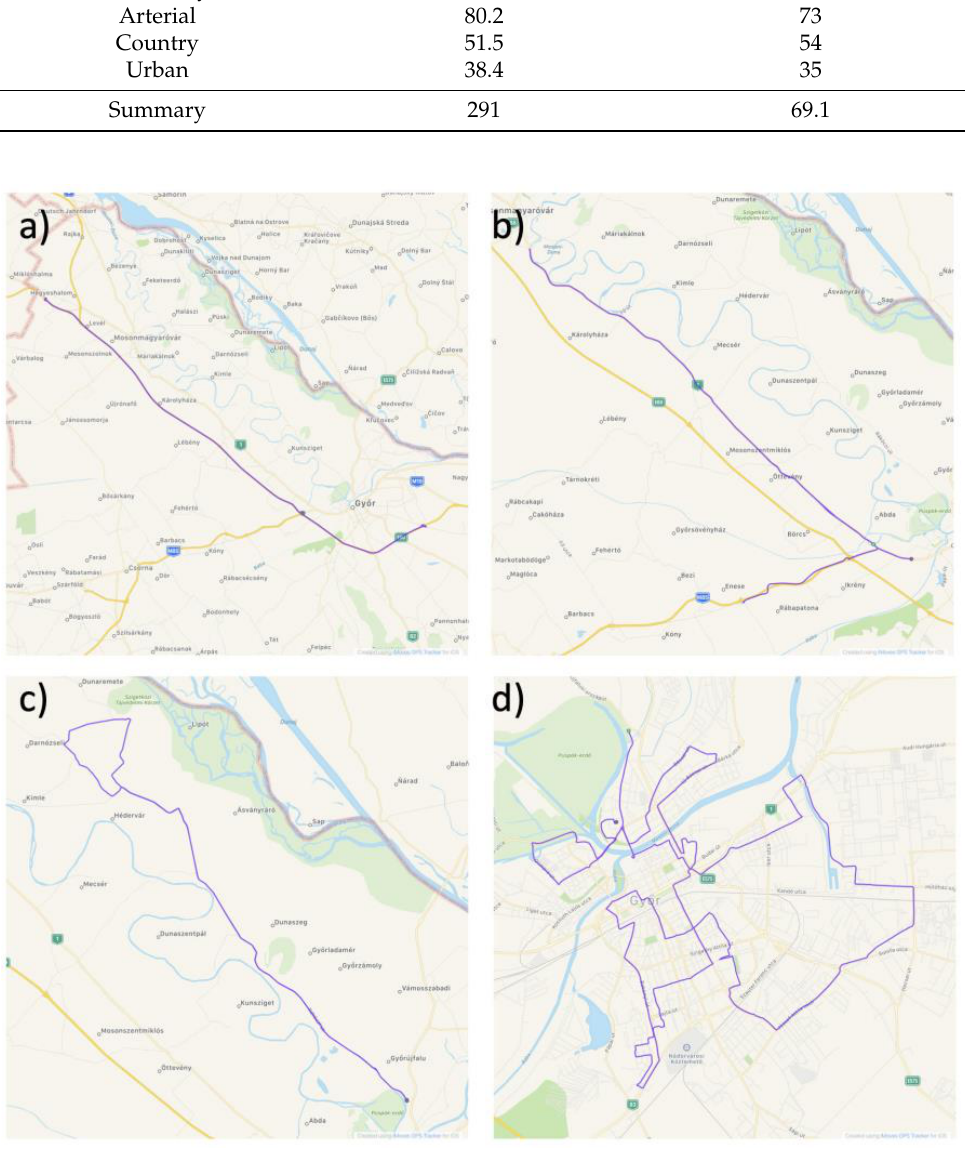
Figure 4. Measured routes ( a ) Motorway, ( b ) Arterial road ( c ) Country road ( d ) Urban